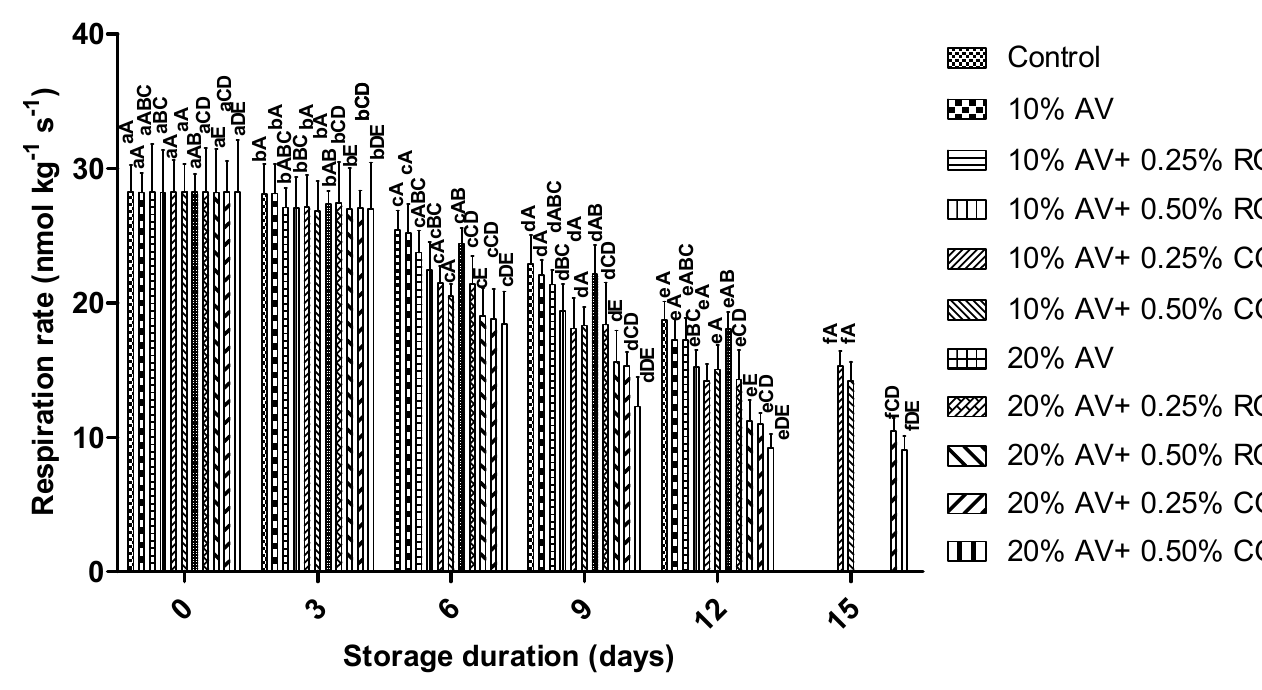
Figure 2. Respiration rate (nmol kg − 1 s − 1 ) of ‘Bhagwa’ pomegranate arils that were coated with Aloe vera (AV) gel coatings that were enriched with rosehip oil (RO) (0.25% or 0.50%) and cinnamon oil (CO) (0.25% or 0.50%) and stored at 5 ± 1 °C (95 ± 2% RH) for 15 days. The vertical bars represent the standard deviation (SD) of the mean values of three replicates (1 punnet = 1 replicate, n = 3). Values bearing at least one common small superscript (a,b,…, etc.) and at least one common capital superscript (A,B,…, etc.) letters differ significantly between the days and between the coating solution/concentrations, respectively, at p < 0.05 in Duncan’s multiple comparison post hoc test.